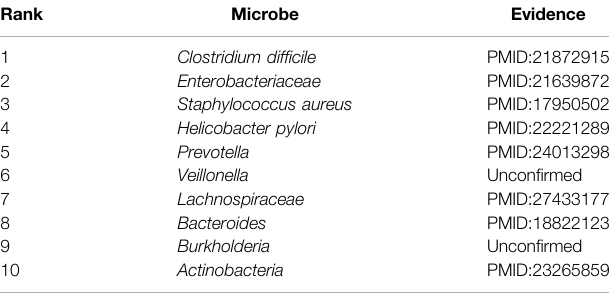
TABLE 6 | The validation results of the top 10 predicted type 2 diabetes (T2D)- related microbes by implementing MSBMFHMDA. Rank Microbe